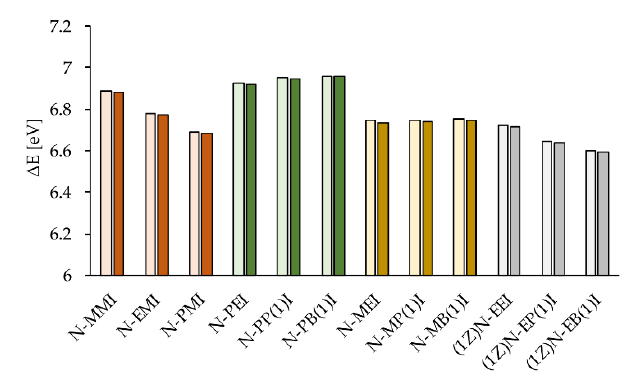
Figure 7. ΔE values of investigated aliphatic Schiff bases in environment of HCl with concentration 1mol/dm 3 (left bars) and 2 mol/dm 3 (right bars) . 1 mol/dm 3 (left bars) and 2 mol/dm 3 (right